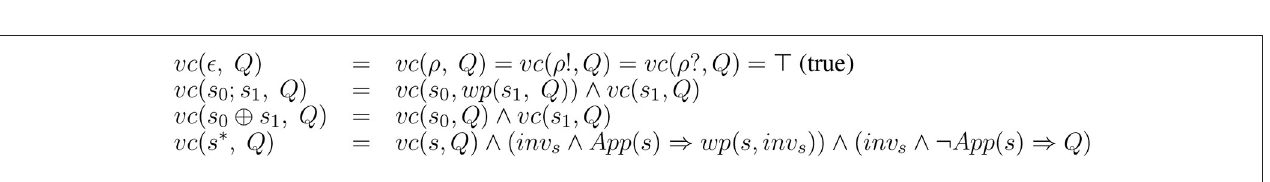
FIGURE 3 | Verification conditions for strategies.